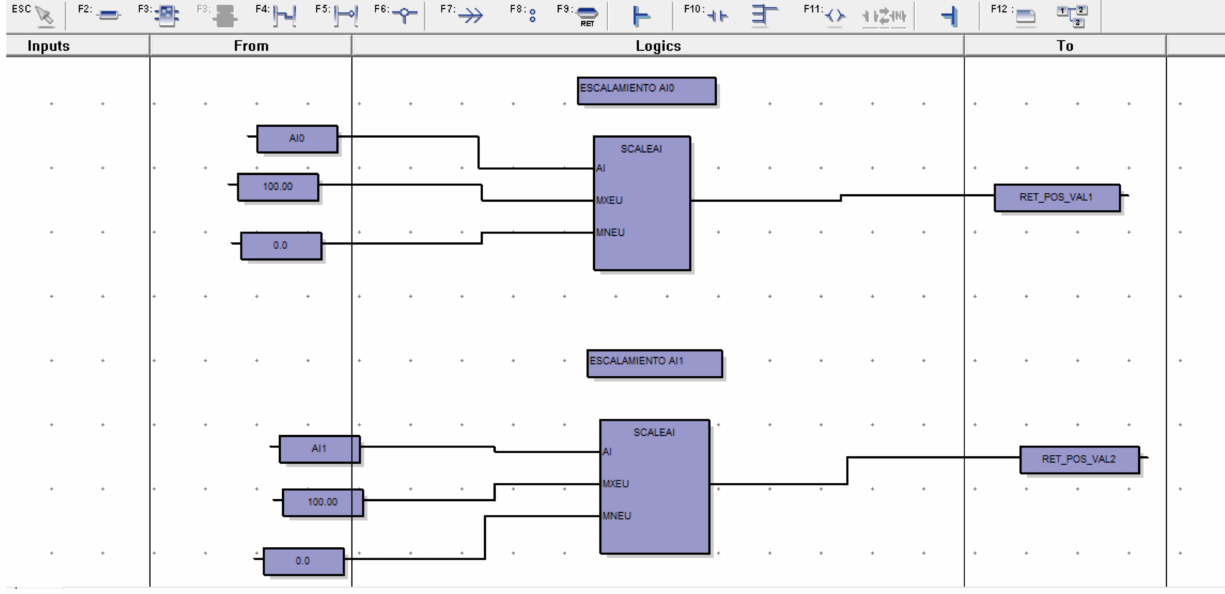
Figure 10. Main program and analog input